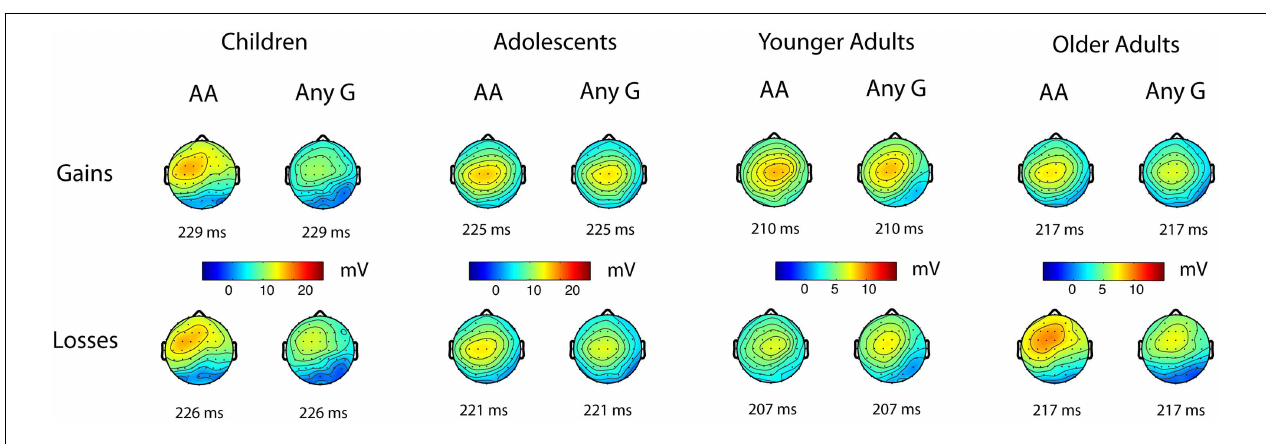
FIGURE 2 | Scalp topographies of the stimulus-locked ERPs to positive and negative feedback for theAA (higher striatal dopamine receptor efficacy) and “any G” (lower striatal dopamine receptor efficacy) genotypes for rs907094 across the four age